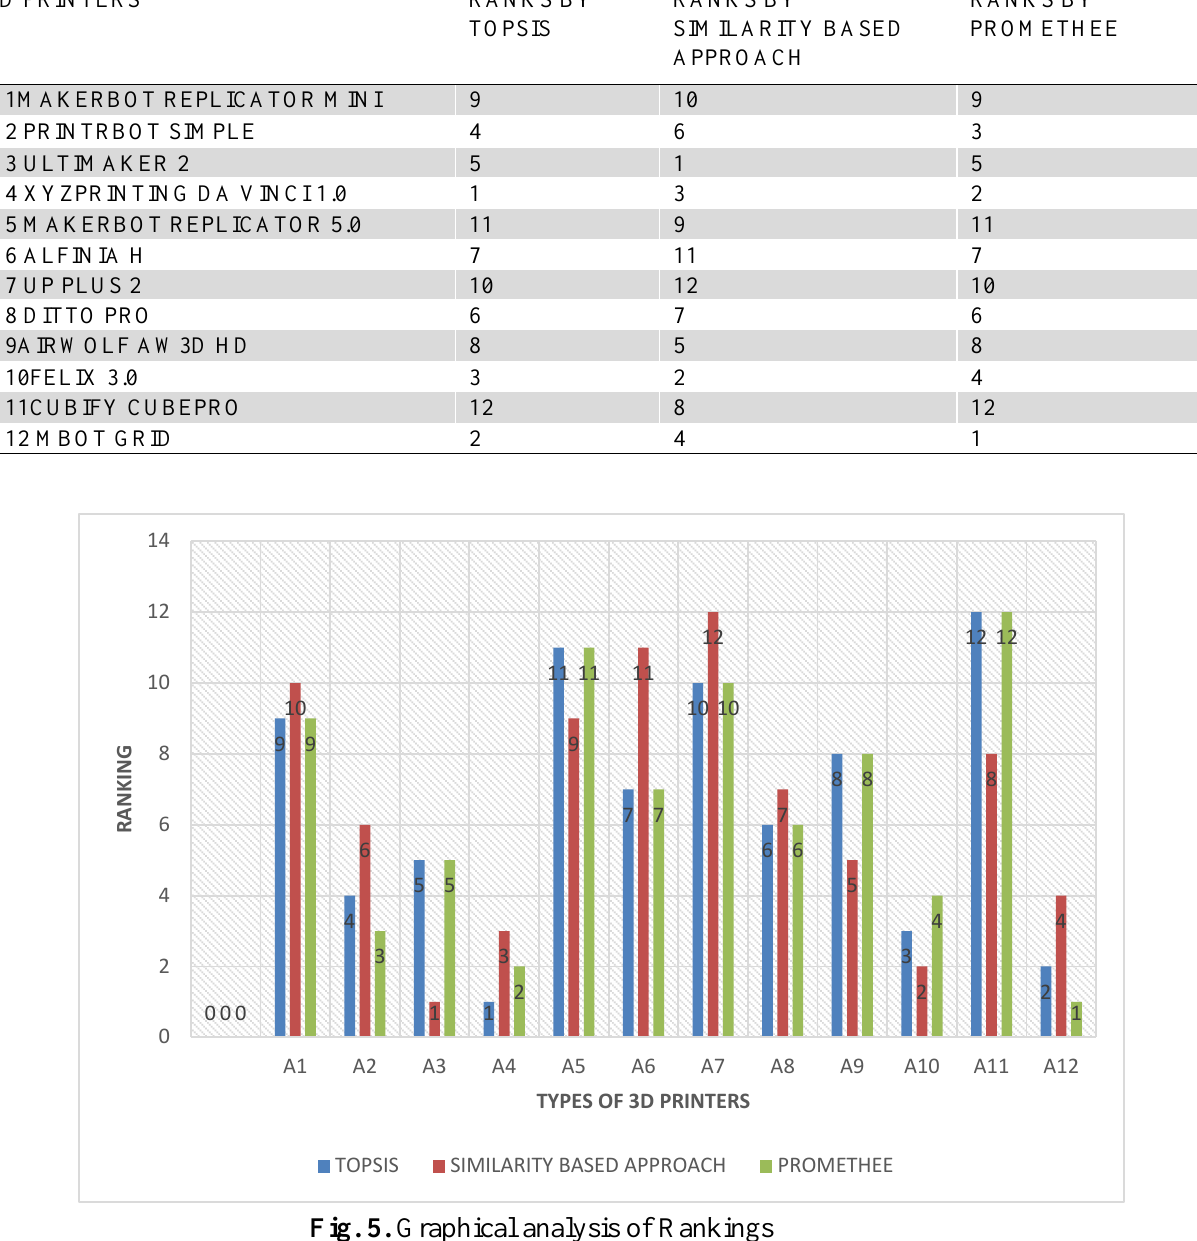
Fig. 5. Graphical analysis of